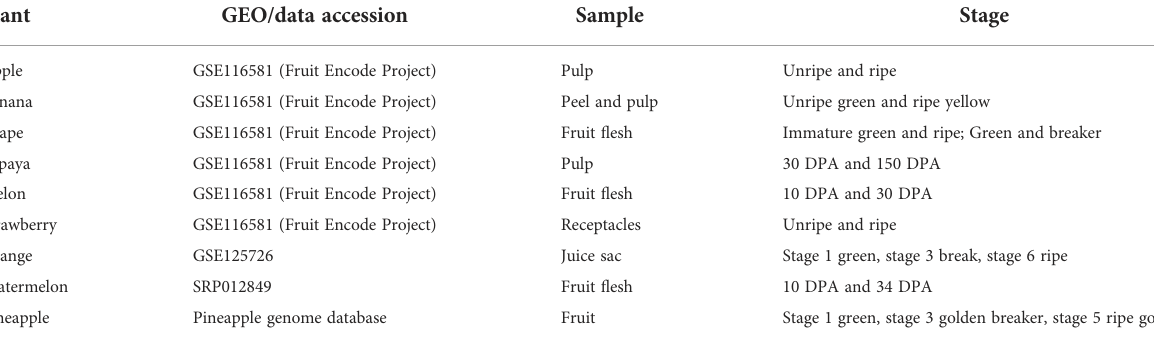
TABLE 1 The fruit stage and sample wise detail of transcriptomic data, used for expression analysis. Plant